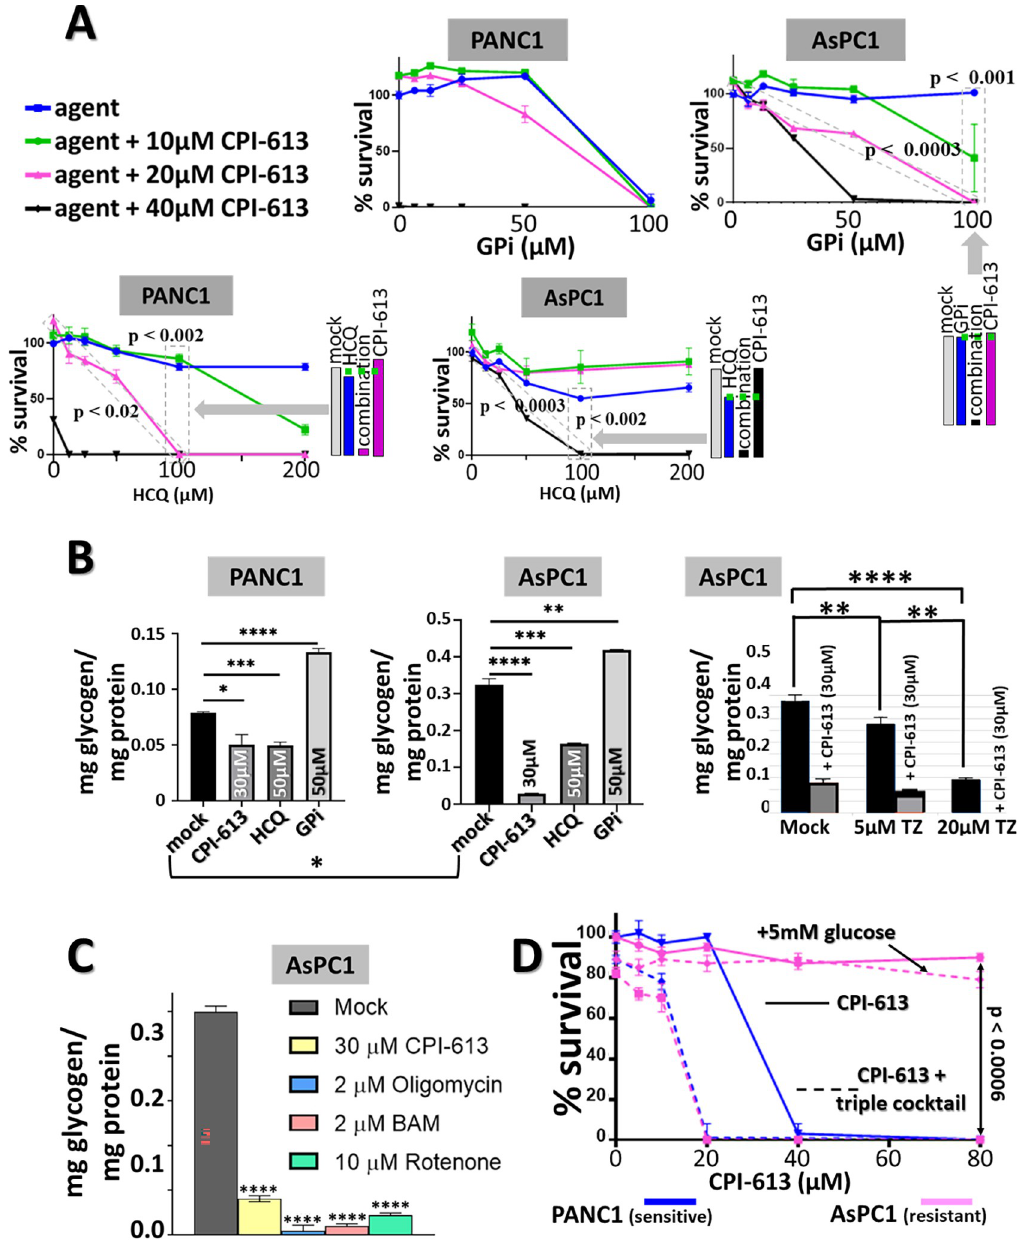
Fig 5. Anti-metabolic agent effects on CPI-613 resistance and glycogen consumption. A. Effects of glycogen phosphorylase inhibitor (CP91149 ; GPi; top row) and autophagy completion blocker hydroxychloroquine (HCQ; bottom row) on sensitivity of PANC1 and AsPC1 cells to CPI-613 killing . Cells were treated with the indicated doses of GPi in the presence of several concentrations of CPI-613 (color-coded lines) for 21hrs, followed by 19hrs of CM/ns recovery (legend to Fig 1A; Materials and Methods). Cells were likewise treated with the indicated doses of HCQ for 20hrs, followed by 24hrs of CM/ns recovery. Bar graphs illustrate examples of enhancement effects in boxed point sets as indicated by grey block arrows. The dashed green lines indicate the expected effects if the two agents act independently. B. Agent effects on glycogen consumption . Cells were treated in the absence of exogenous nutrients (CBS2) for 3hrs with the indicated agents (plating sequence as in Fig 1A). Note the different vertical scales for PANC1 and AsPC1 plots. C. Mechanistically diverse mitochondrial poisons mimic CPI-613 , inducing accelerated glycogen depletion in AsPC1 cells . Glycogen content measurements in cells treated with the indicated concentration of each inhibitor in the absence of exogenous nutrients (CBS2) for 3hrs (plating sequence as in Fig 1A). Statistical significance symbols reflect comparison of each treatment to mock treated control. � indicates p < 0.05. �� indicates p < 0.01. ��� indicates p < 0.001. ���� indicates p < 0.0001. D. Triple cocktail CPI-613 sensitization in AsPC-1 . Cells were treated for 16hrs in